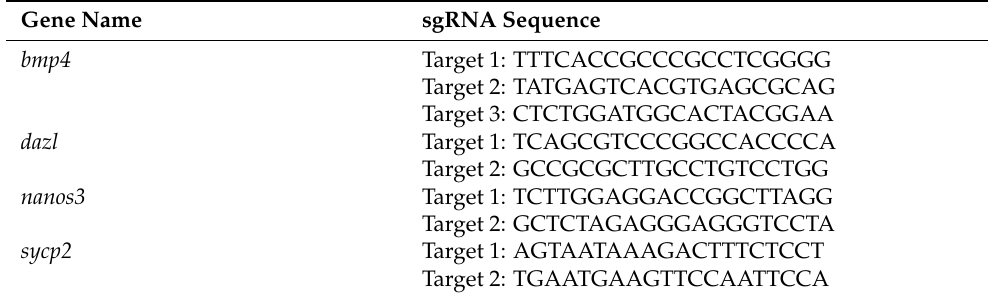
Table 3. sgRNA sequences of four